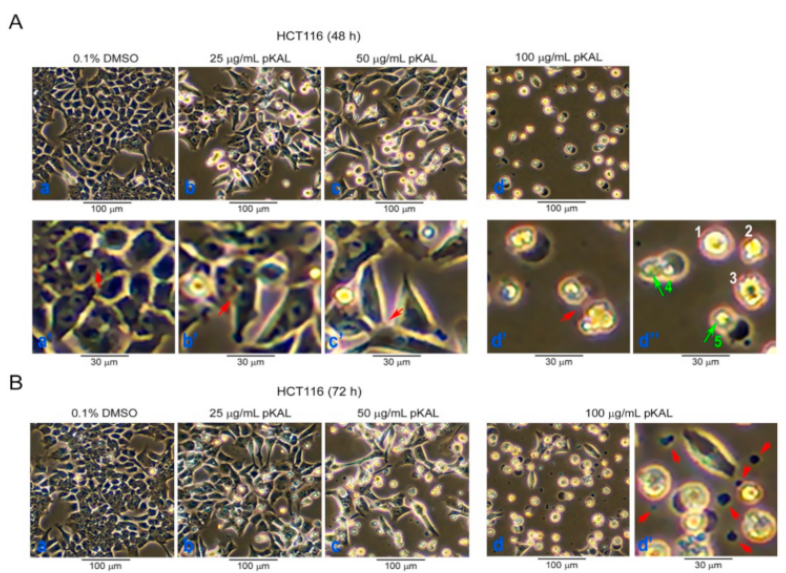
Figure 1. Effect of the Korean plant Artemisia annua L. (pKAL) on the regulation of cell morphology in p53 wild-type HCT116 colorectal cancer cells: HCT116 cells were grown with the indicated amount of DMSO or pKAL for 48 h ( A ) and 72 h ( B ) and analyzed by phase-contrast light microscopy. Panels a’–d’ were enlarged from panels a–d, respectively, and panel d” was enlarged from panel